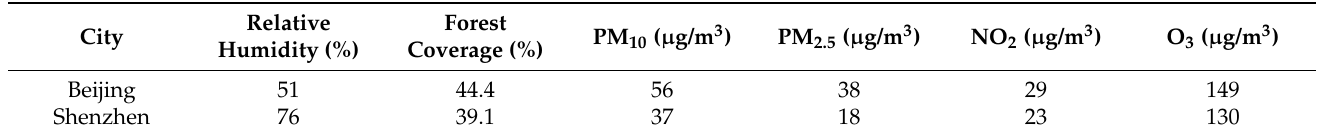
Figure 1. ( A ) Location of Beijing and Shenzhen. ( B ) An aerial view of Beijing showing the sampling sites. ( C ) An aerial view of Shenzhen showing the sampling sites (Notes: Blue squares represent the sampling sites in greenbelts adjacent to a highway. Red squares represent the sampling sites in urban parks). Table 1. Detailed information on Beijing and Shenzhen (Note: Data are averages obtained from the local municipal environment bulletins).